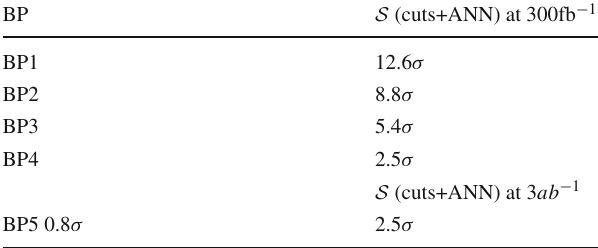
Table 4 Signal significance for the benchmark points at 14 TeV LHC with cuts+ANN